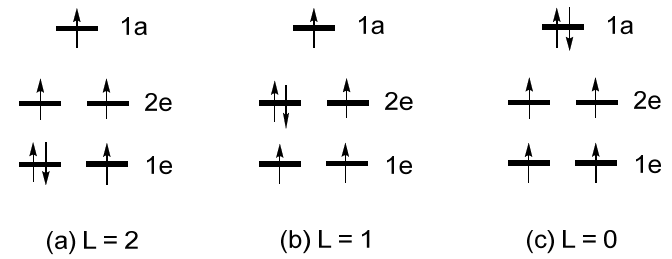
Figure 7. Three electron configurations of Fe L 2 based on the d-state split pattern of 1e < 2e < 1a: ( a ) L = 2, ( b ) L = 1 and ( c ) L = 0 configurations.